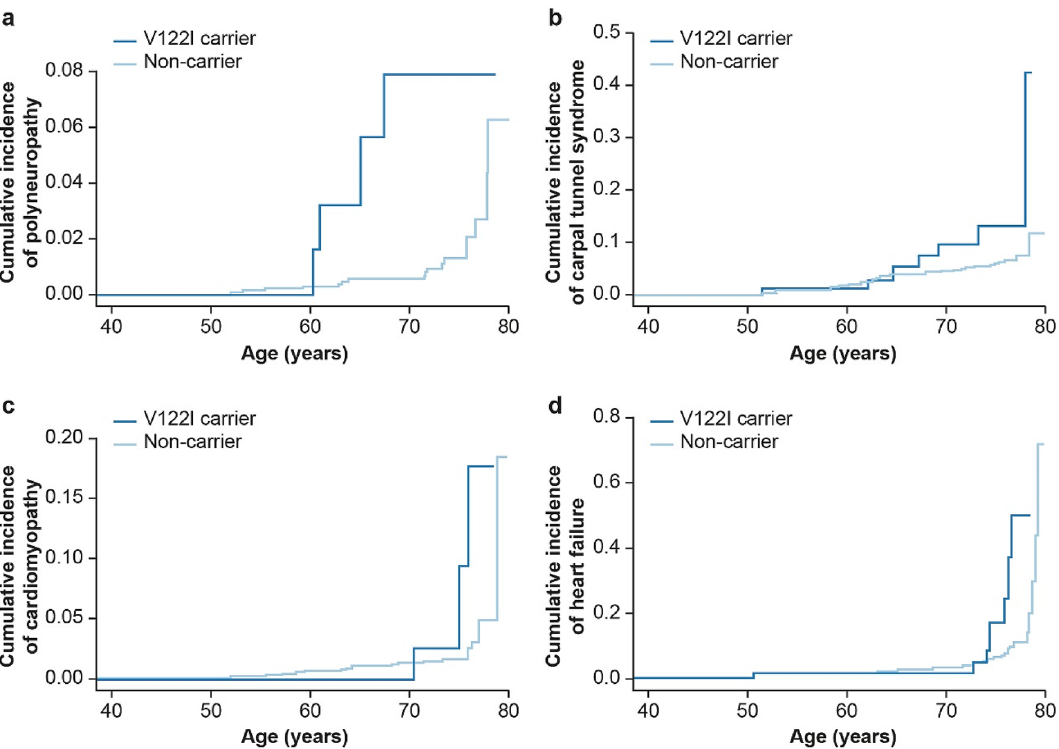
Figure 3. Cumulative incidence by V122I genotype of first diagnosis of common hereditary transthyretin- mediated amyloidosis manifestation: ( a ) polyneuropathy (G62), ( b ) carpal tunnel syndrome (G560), ( c ) cardiomyopathy (I42), and ( d ) heart failure (I50 or I098). V122I valine-to-isoleucine substitution at position 122.